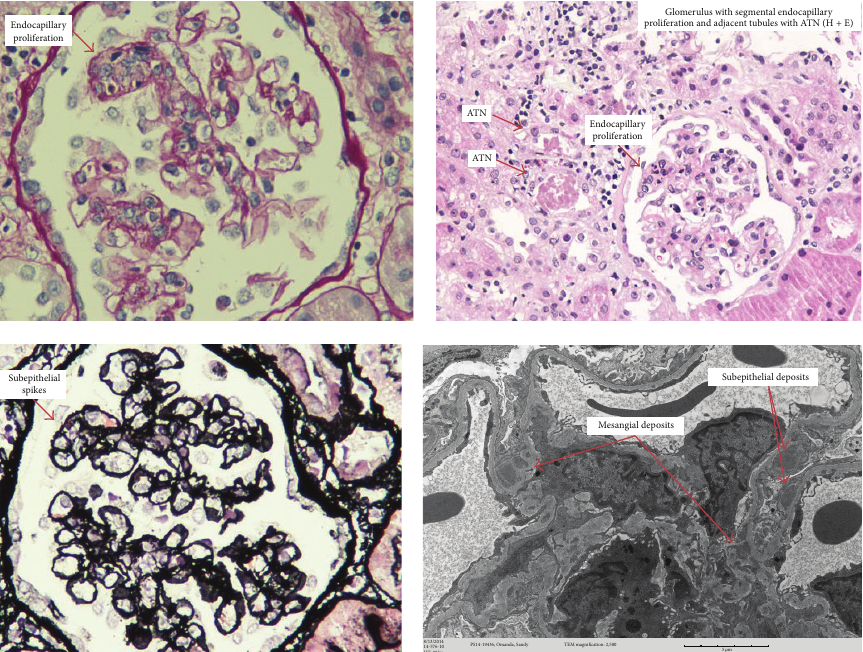
Figure 3: Kidney biopsy: membranous and focal lupus nephritis [ISN/PPS 2004 classification lupus nephritis, classes III (A) and V]; acute tubular